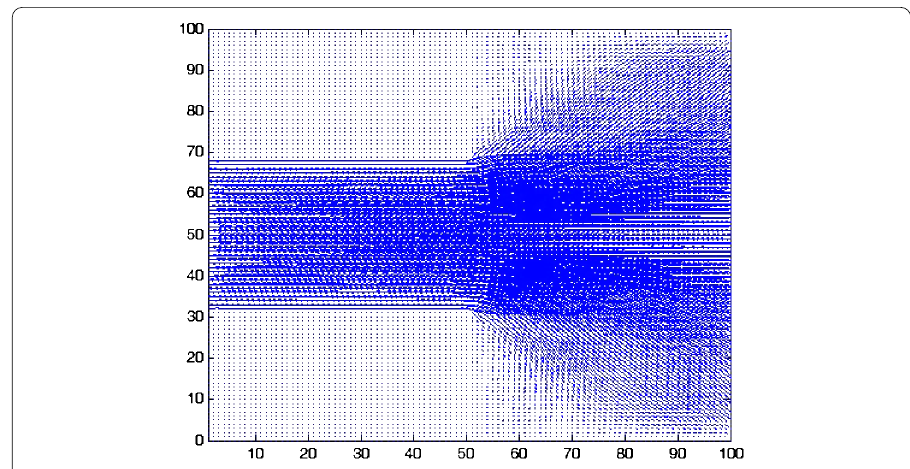
Figure 1 The streamline of the SMFE solution of the fluid velocity u at t = 10.